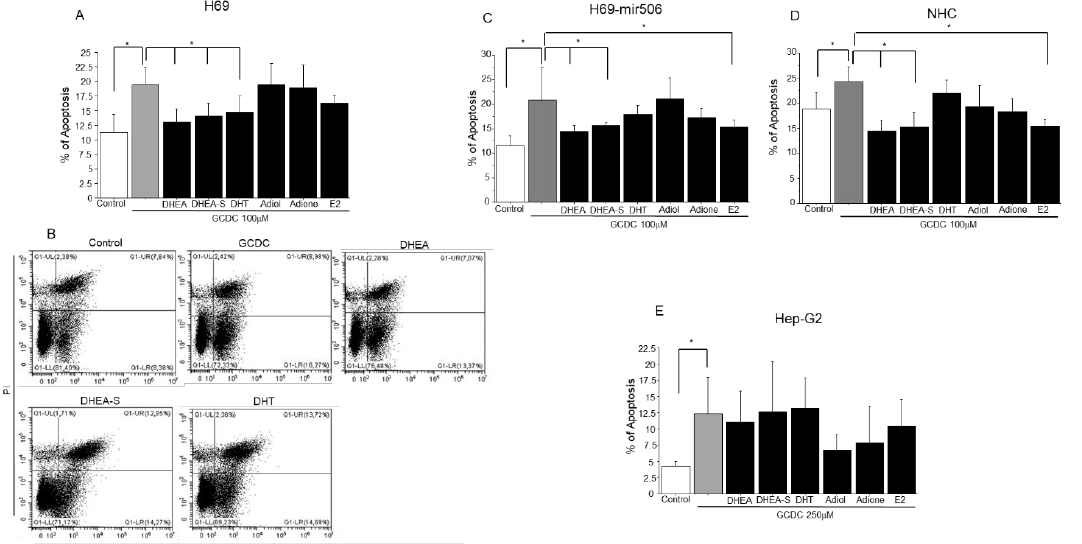
Figure 1. The effect of DHEA and its metabolites on the proliferation of cholangiocytes (H69, H69- miR506, and NHC) and hepatocytes (Hep-G2). Different cells types i.e., cholangiocytes ( A – C ) and hepatocytes ( D ) were incubated with DHEA and its metabolites (DHEA-S, DHT, adiol, adione and E2). Cells were harvested 48 h after treatment by scraping and were counted using CytoFLEX LX flow cytometer. Acquisition time was 60 s, and the sample flow rate was set at 60 μL/min. Results are presented as a mean ± SEM ( n = 3); * p < 0.05; ** p < 0.01.